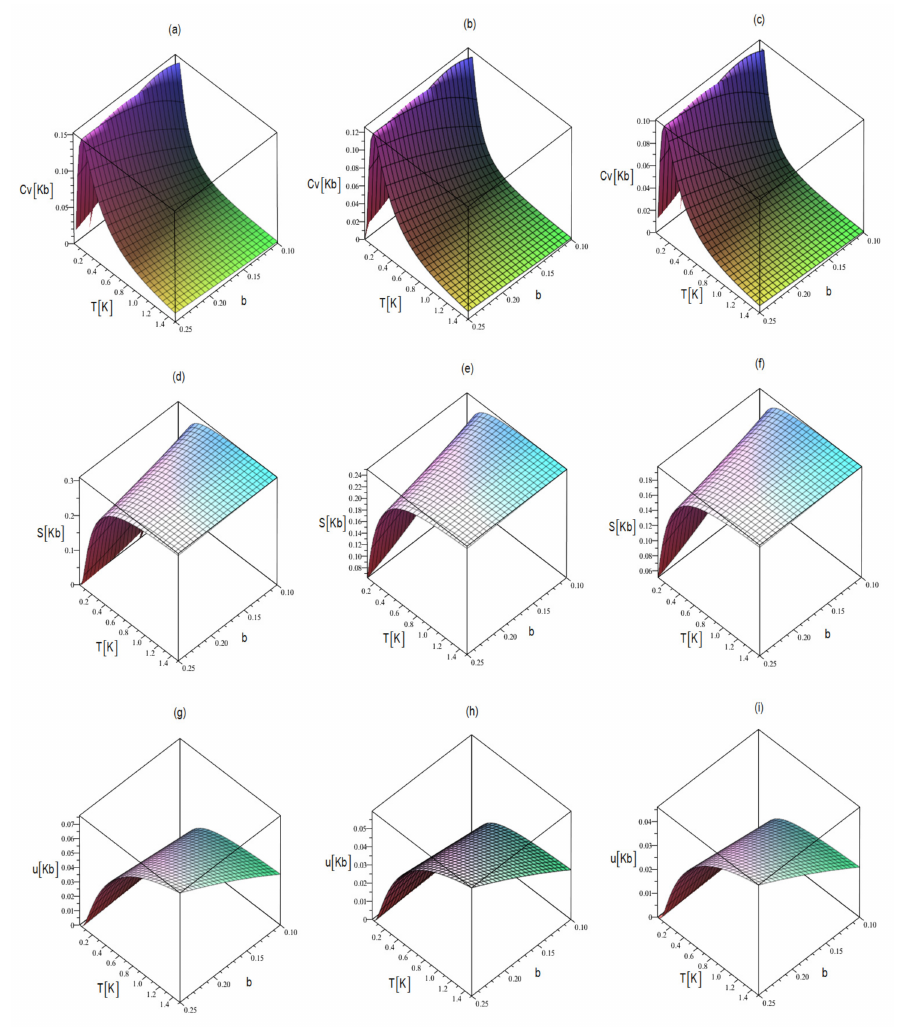
Figure 2. Thermodynamic magnitudes. ( a – c ) represent the specific heat, ( d – f ) entropy, and ( g – i ) the internal energy. The plots of each row are carried out with θ = 0.625 , θ = 0.800 , θ = 1.00 , respectively, and with the b energy in the interval 0.1 ≤ b ≤ 0.25 in Equations (3)–(5). The temperature varies from 0 to 1.5 K. The results present a similar qualitative pattern, although with substantial quantitative